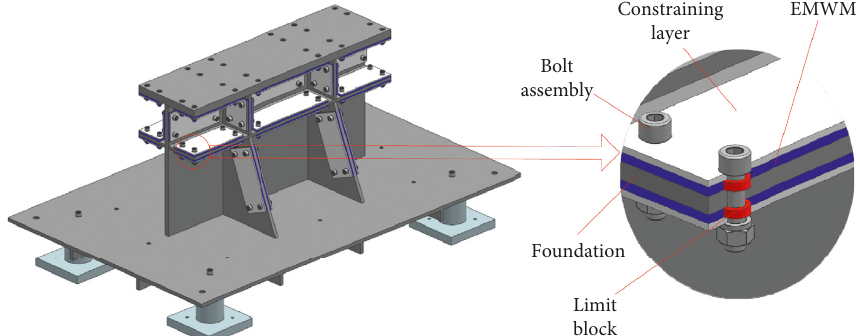
Figure 8: Arrangement scheme of the composite foundation.